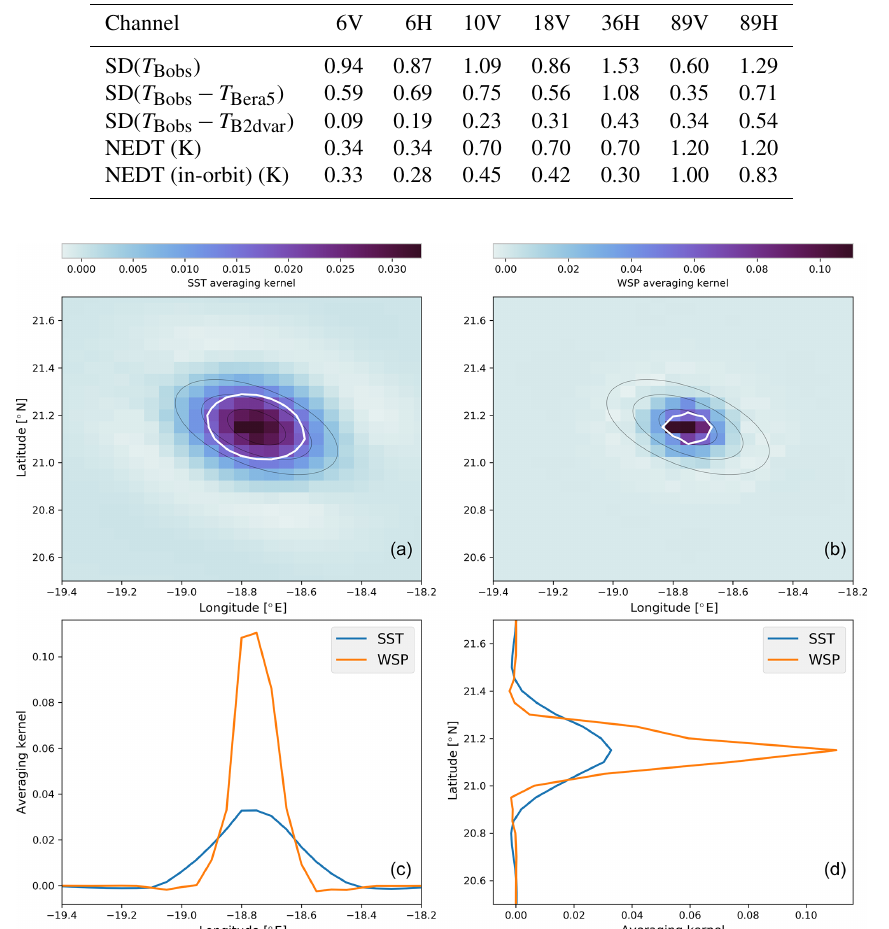
Table 2. Standard deviations (SD) of observed ( T Bobs ) and simulated brightness temperatures from the scene observed in Fig. 6, from the forward model applied to data from ERA5 ( T Bera5 ) and the retrieved state from the 2D-Var ( T B2dvar ). Only selected channels are given. Approximate in-orbit NEDT values are from Kasahara et al. (2015).